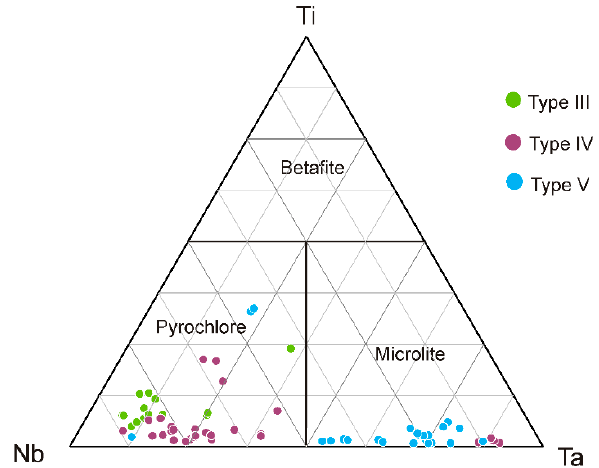
Figure 19. Nb-Ta-Ti compositional plot of the pyrochlore-supergroup minerals from the Giraúl pegmatites. Black solid lines after [45].